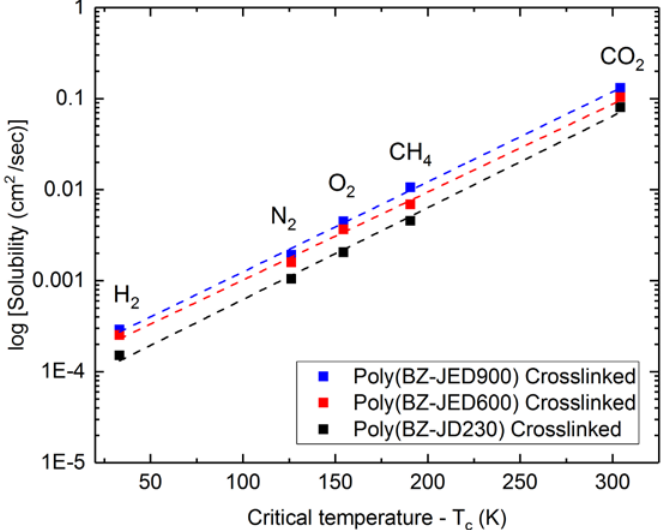
Figure 5. Dependence of gas solubility coefficients as a function of critical temperature (T c ) of gas molecules for PEG-based polybenzoxazine.